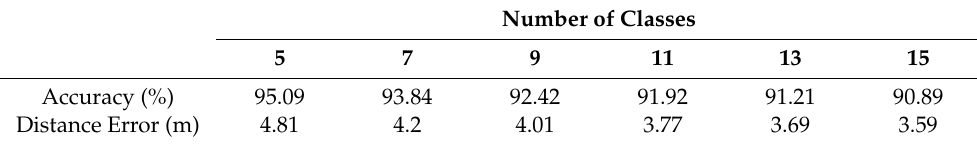
Table 1. Results for the pretrained model using the proposed speed estimation approach. Number of